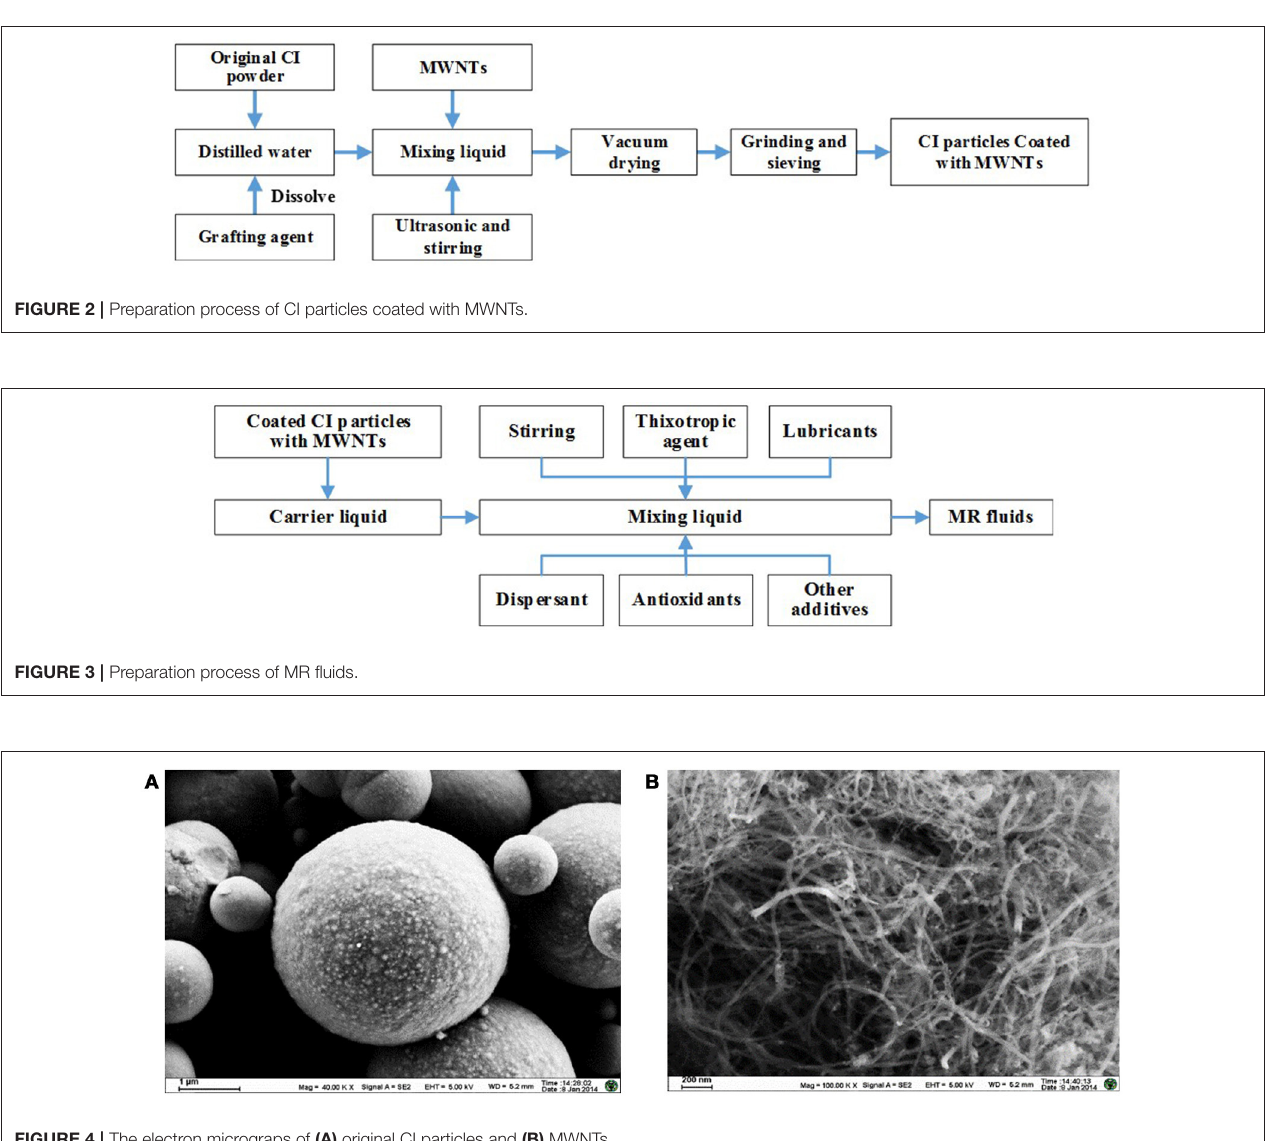
FIGURE 4 | The electron micrograps of (A) original CI particles and (B) MWNTs.